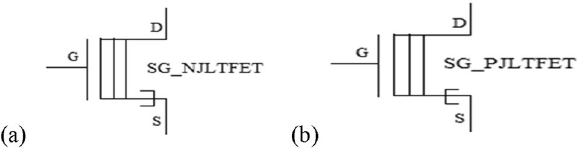
Figure 3. Symbol of shorted gate ( a ) SG_NJLTFET and ( b )